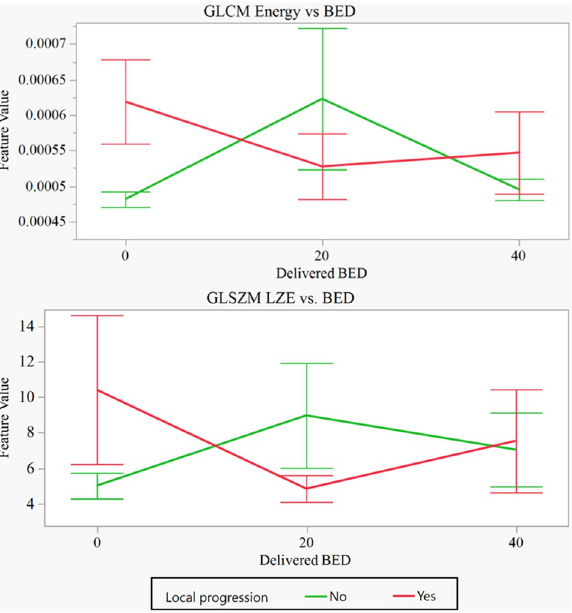
Figure 3. Mean feature values for patients prior to delivery (BED = 0 Gy), after delivery of BED 20 Gy, and after BED 40 Gy. Both radiomics texture features for the patients without local progression behaved similarly with increased values from BED 0 Gy to BED 20 Gy and decreasing from BED 20 Gy to the BED 40 Gy point (in green). The patients with local progression displayed the opposite, feature values initially decreased from BED 0 to BED 20 then increased from BED 20 Gy to BED 40 Gy. With no multiple test statistical comparisons GLCM energy extracted from the first set up image had a p value ≤ 0.05 at BED 0 Gy point. However, after applying the Bonferroni correction, it was not statistically significant ( p value > 0.05). BED = biologically effective dose (calculated using α/β = 10), GLCM: gray level co-occurrence matrix, GLSZM: gray level size zone matrix, LZE: large zone emphasis. The vertical bars represent the standard error of each